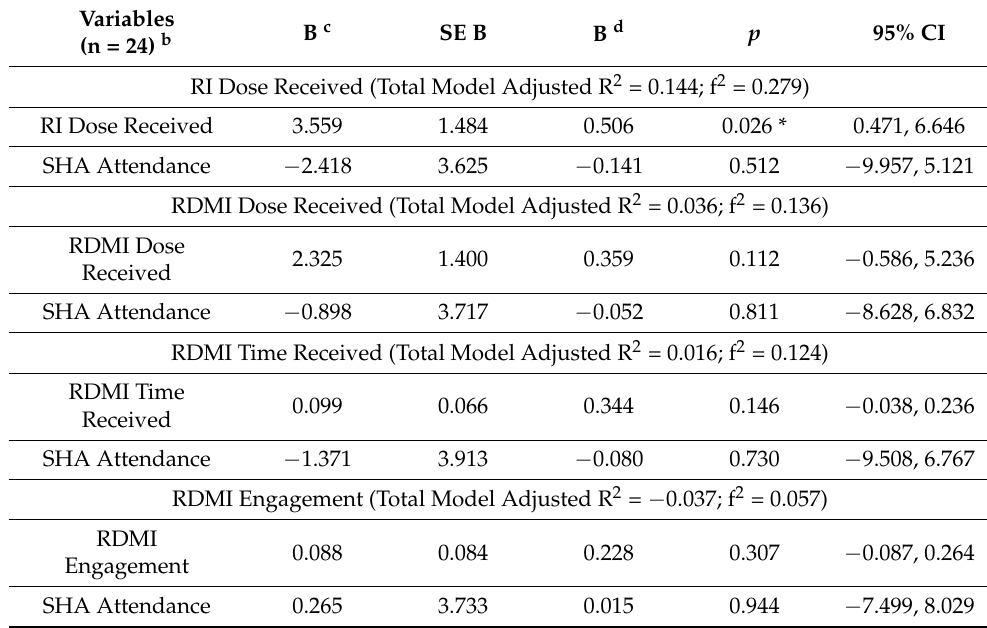
Table 4. Multiple Linear Regression for Measures of RDMI Dose, Summer Harvest Adventure Attendance, and Changes in PAC Modeling a